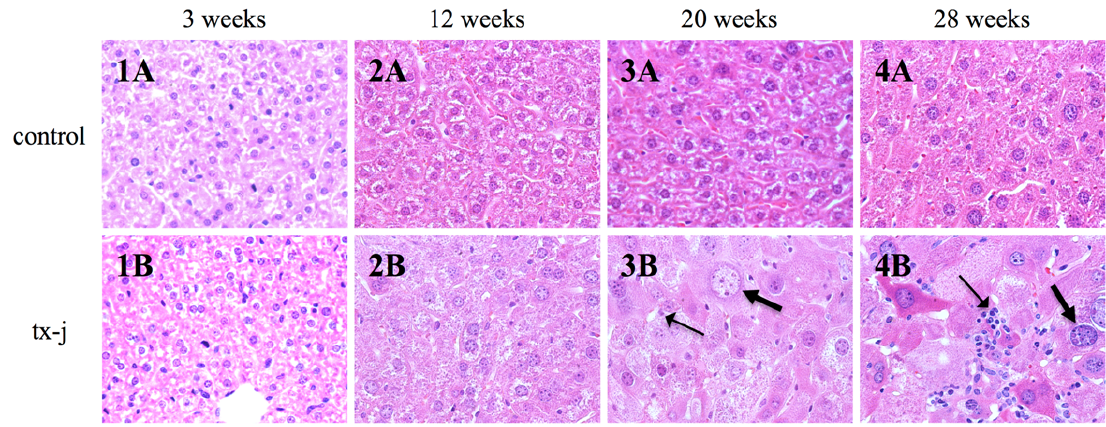
Figure 3. Histology images of tx-j and control livers from three to 28 weeks of age. All hematoxylin and eosin stained, 436×. Whereas liver histology was normal in tx-j mice at both three and 12 weeks of age ( 1B and 2B ), there was an increase in inflammatory infiltrates at 20 and 28 weeks ( 3B and 4B , thin arrows), in association with giant nuclei and markedly increased cell size of the hepatocytes ( 3B and 4B , thick arrows). Note that in tx-j mice hepatocyte cell diameters are 2.5 times and nuclear diameters are about two times larger than control mice [19]. Control mice had normal liver histology at all time points ( 1A , 2A , 3A and 4A